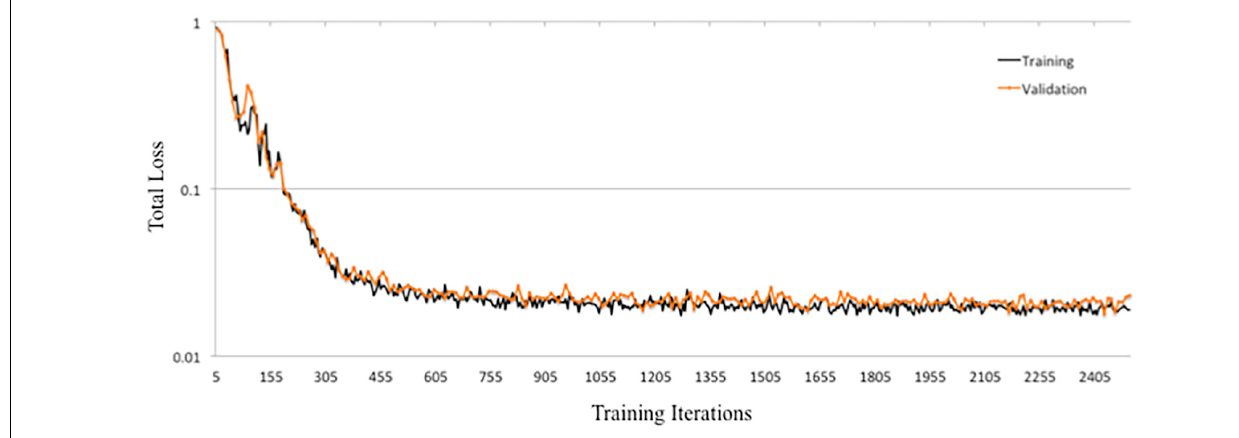
FIGURE 6 | Training and validation learning curves for DeepNavNet Model-1.